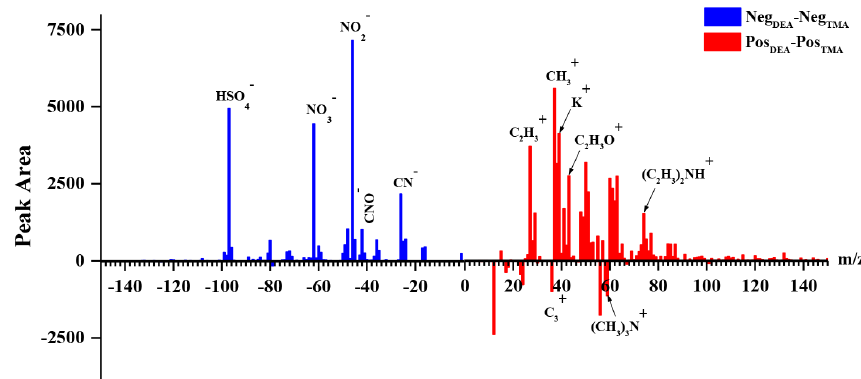
Figure 6. Differential mass spectra between DEA- and TMA-containing particles.